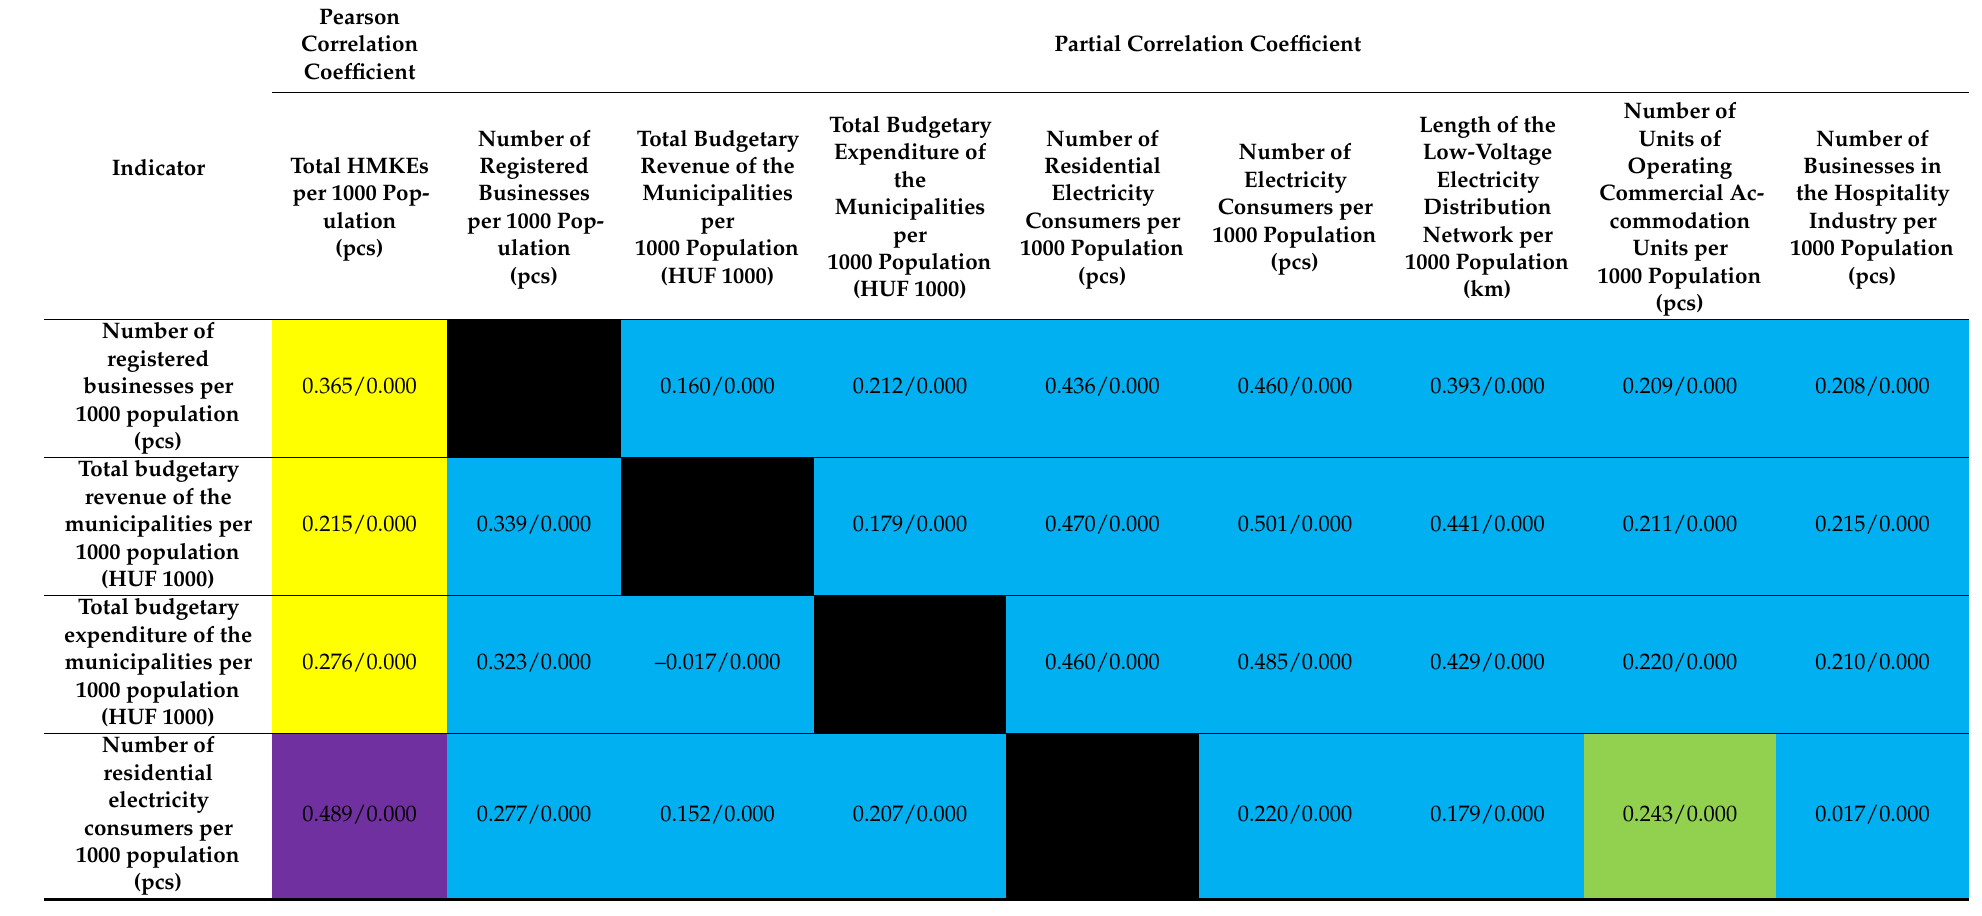
Table 3. The strength of the relationship between the quantity of the total HMKE per 1000 population and the settlement indicators 1 ( 1 Pearson correlation coefficient/ p -value; if p < 0.05, then there is a significant verified relationship between the two variables) (In the case of the Pearson correlation coefficients in the table yellow background means weak moderate and purple moderately close correlations.) In the case of the partial correlation the green background signals cases where the background variable did not cause any difference in the strength of the relationship, while blue background indicates partial explanation (the controlled variable explains the relationship between variables i and j only partially), and black marking shows irrelevant